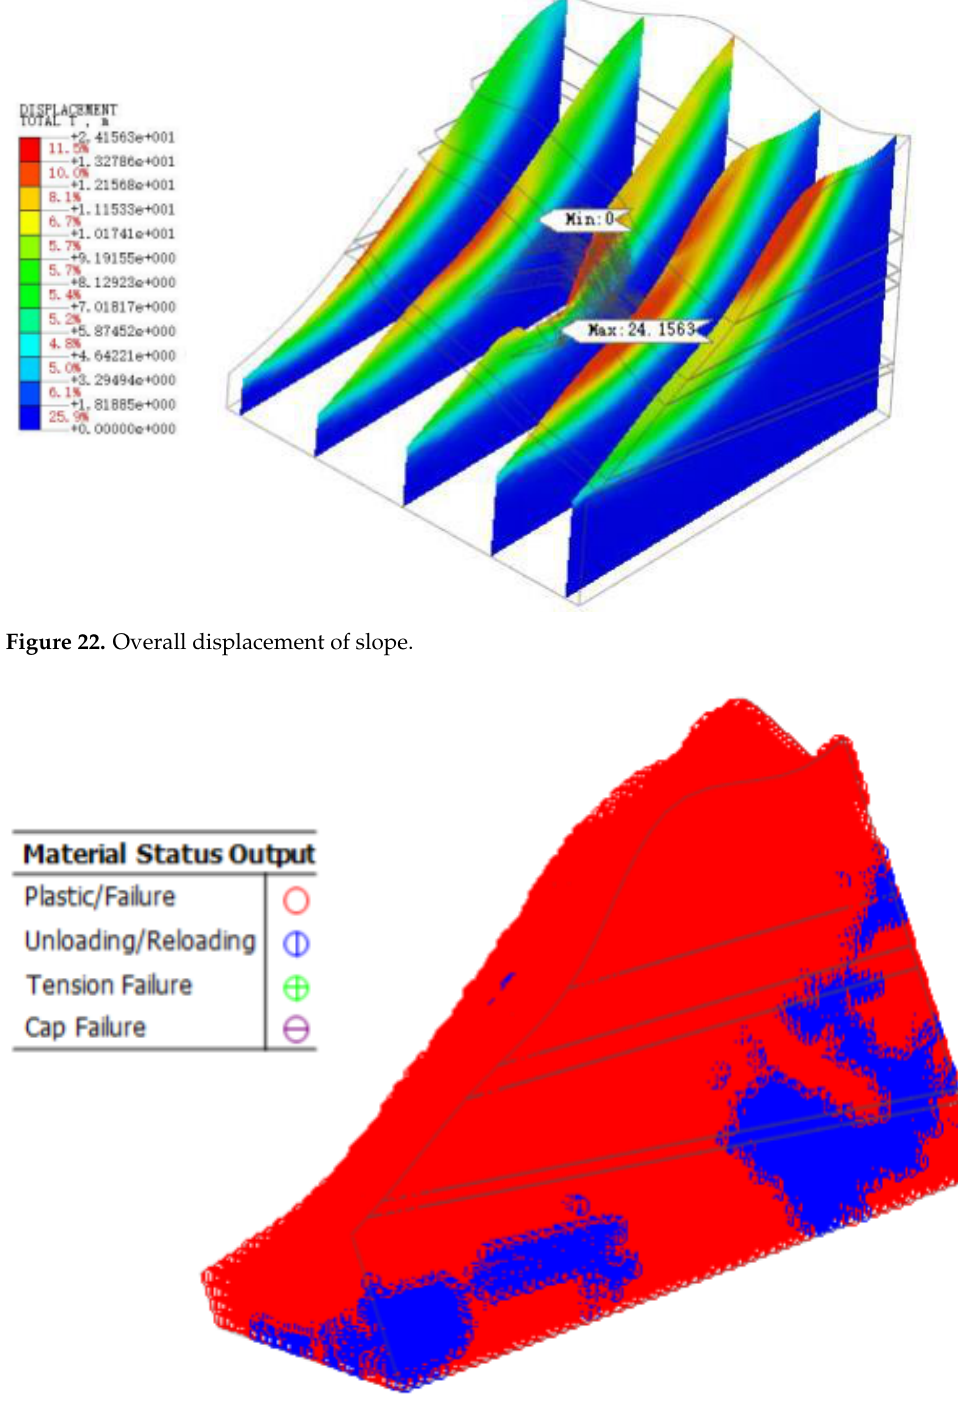
Figure 23. Plastic zone range of slope.